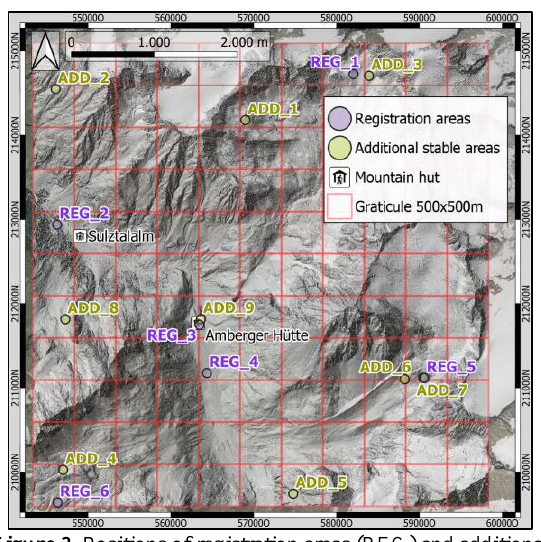
Figure 3 . Positions of registration areas (REG) and additional validation areas (ADD). Orthophoto WMS for Tyrol/Austria, Relief shading based on ALS 2017: Federal State of Tyrol,